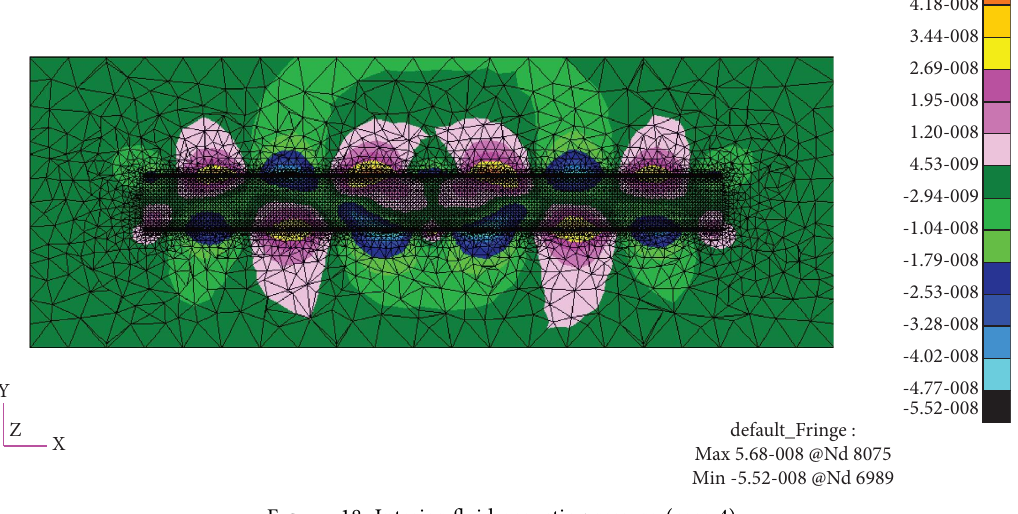
Figure 18: Interior fuid acoustic pressure (case